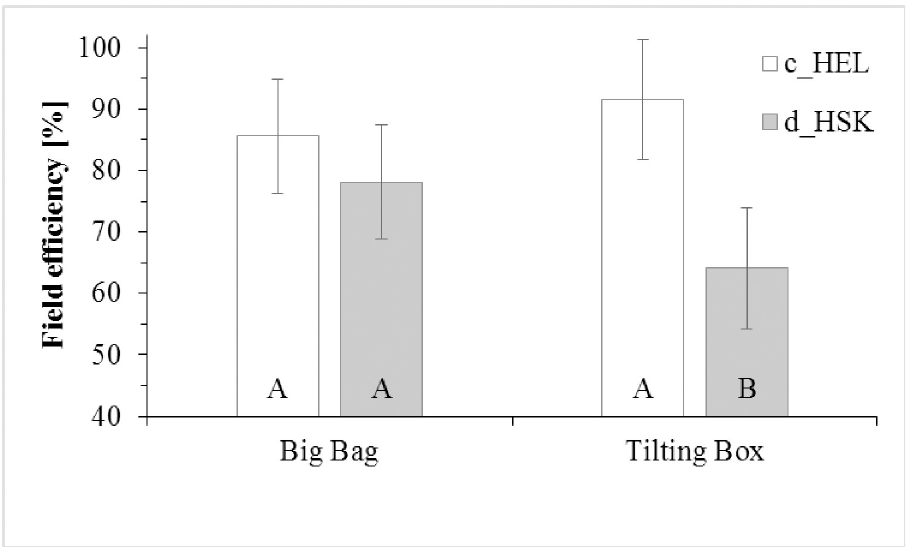
Fig 3. Field efficiency (%) of the wood chipper prototype equipped with a big bag or tilting box and with either continuous helicoidal knifes (c_HEL) or discontinuous hoe shaped knife (d_HSK). Bars are the LSmeans ± standard error estimate. Bars with a letter in common cannot be considered different according to the tukey-kramer grouping applied at the 0.05 of the LSmeans p differences.